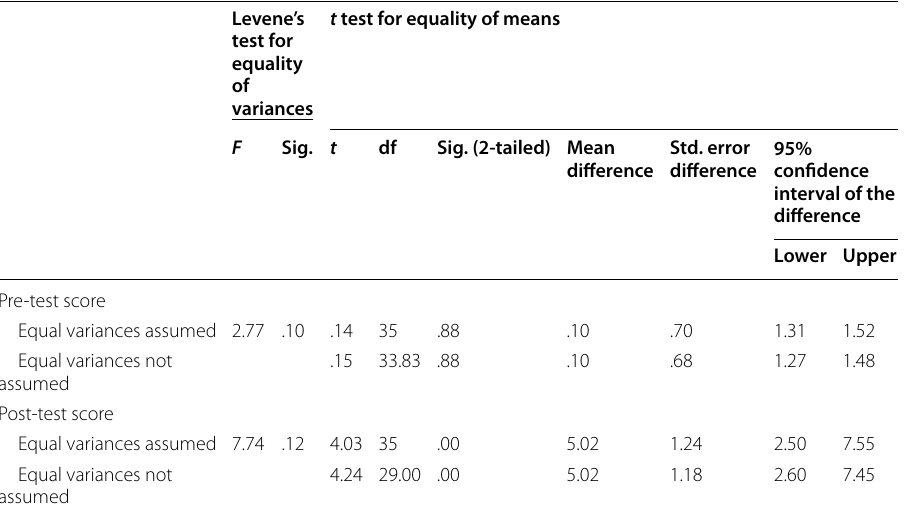
Table 3 Independent samples test